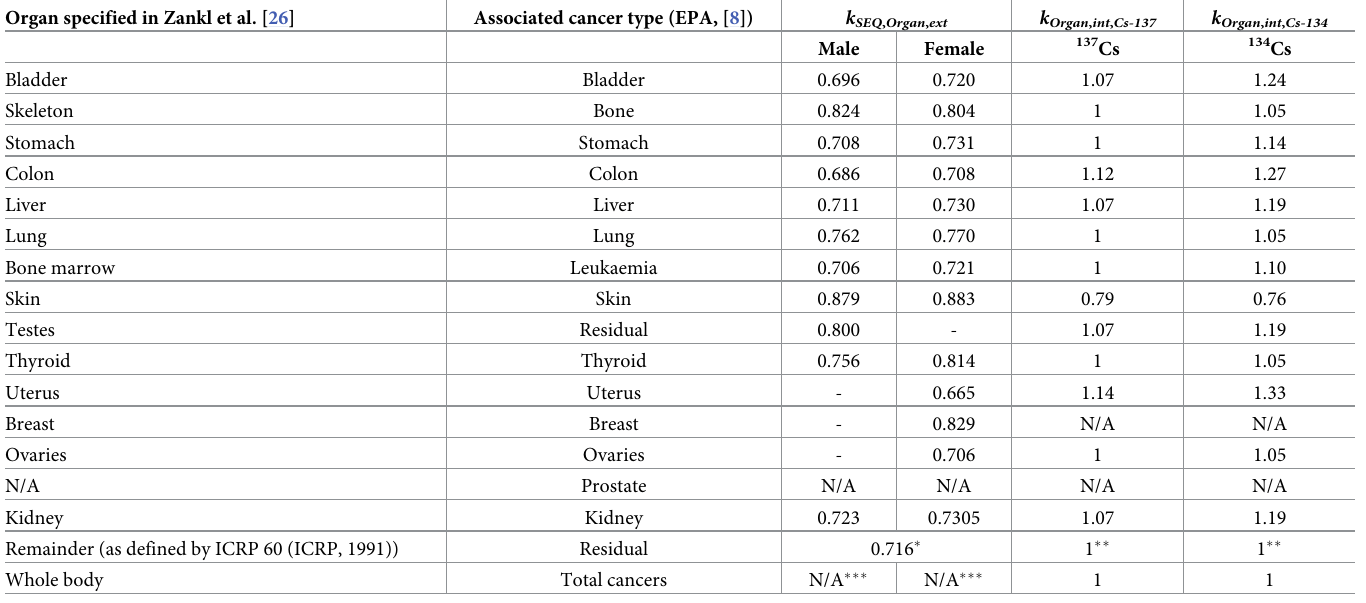
Table 3. Ratios between organ-specific absorbed dose rate and air kerma rate for a gamma-emitting surface source of 600 keV [26]. Organ-specific ratio between absorbed dose to organ and corresponding whole-body absorbed dose incurred by a uniform distribution of 134 Cs and 137 Cs, respectively [15]. N/A = Not available. Organ specified in Zankl et al. [26]